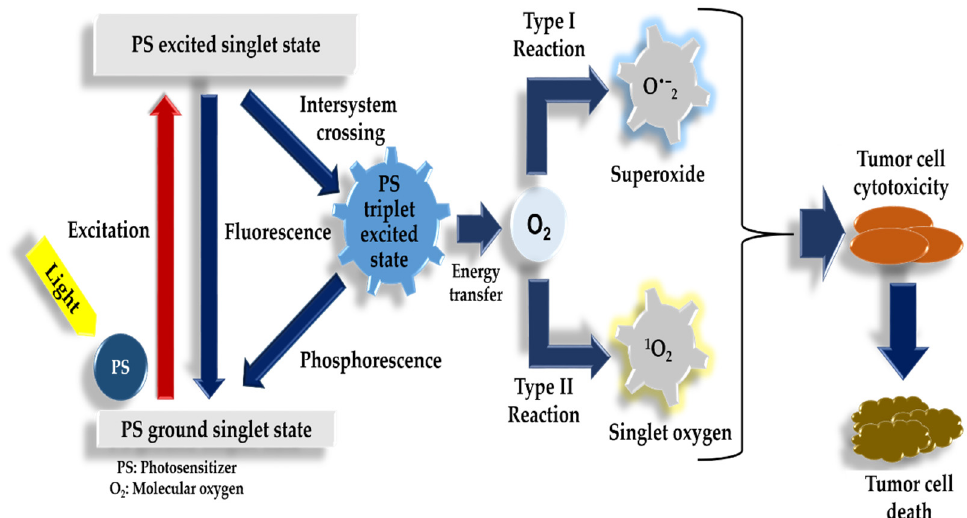
Figure 1. Photodynamic therapy mechanism of action – Type I reaction: generation of superoxide radicals and Type II reaction: generation of singlet oxygen. Generated ROS inducing tumor cell death.